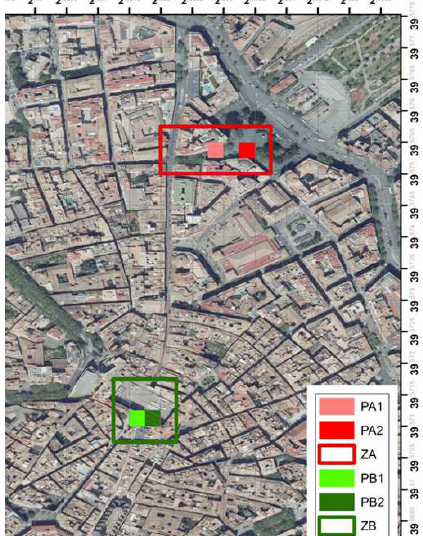
Figure 4. The distribution of studied areas Za with calibration zones PA1 and PA2, ZB with calibration zones PB1 and PB2.